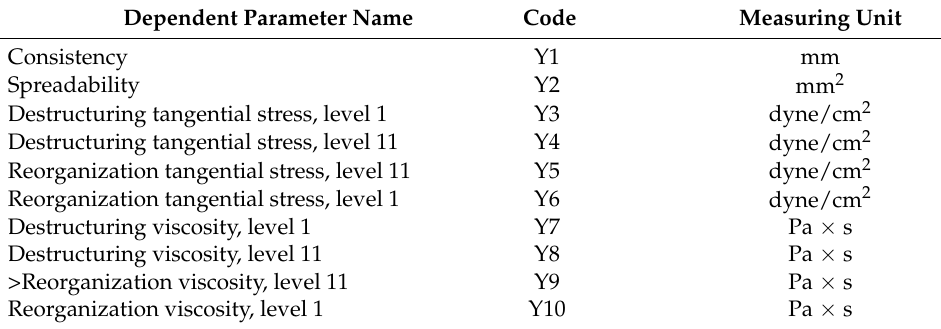
Table 3. The dependent parameters